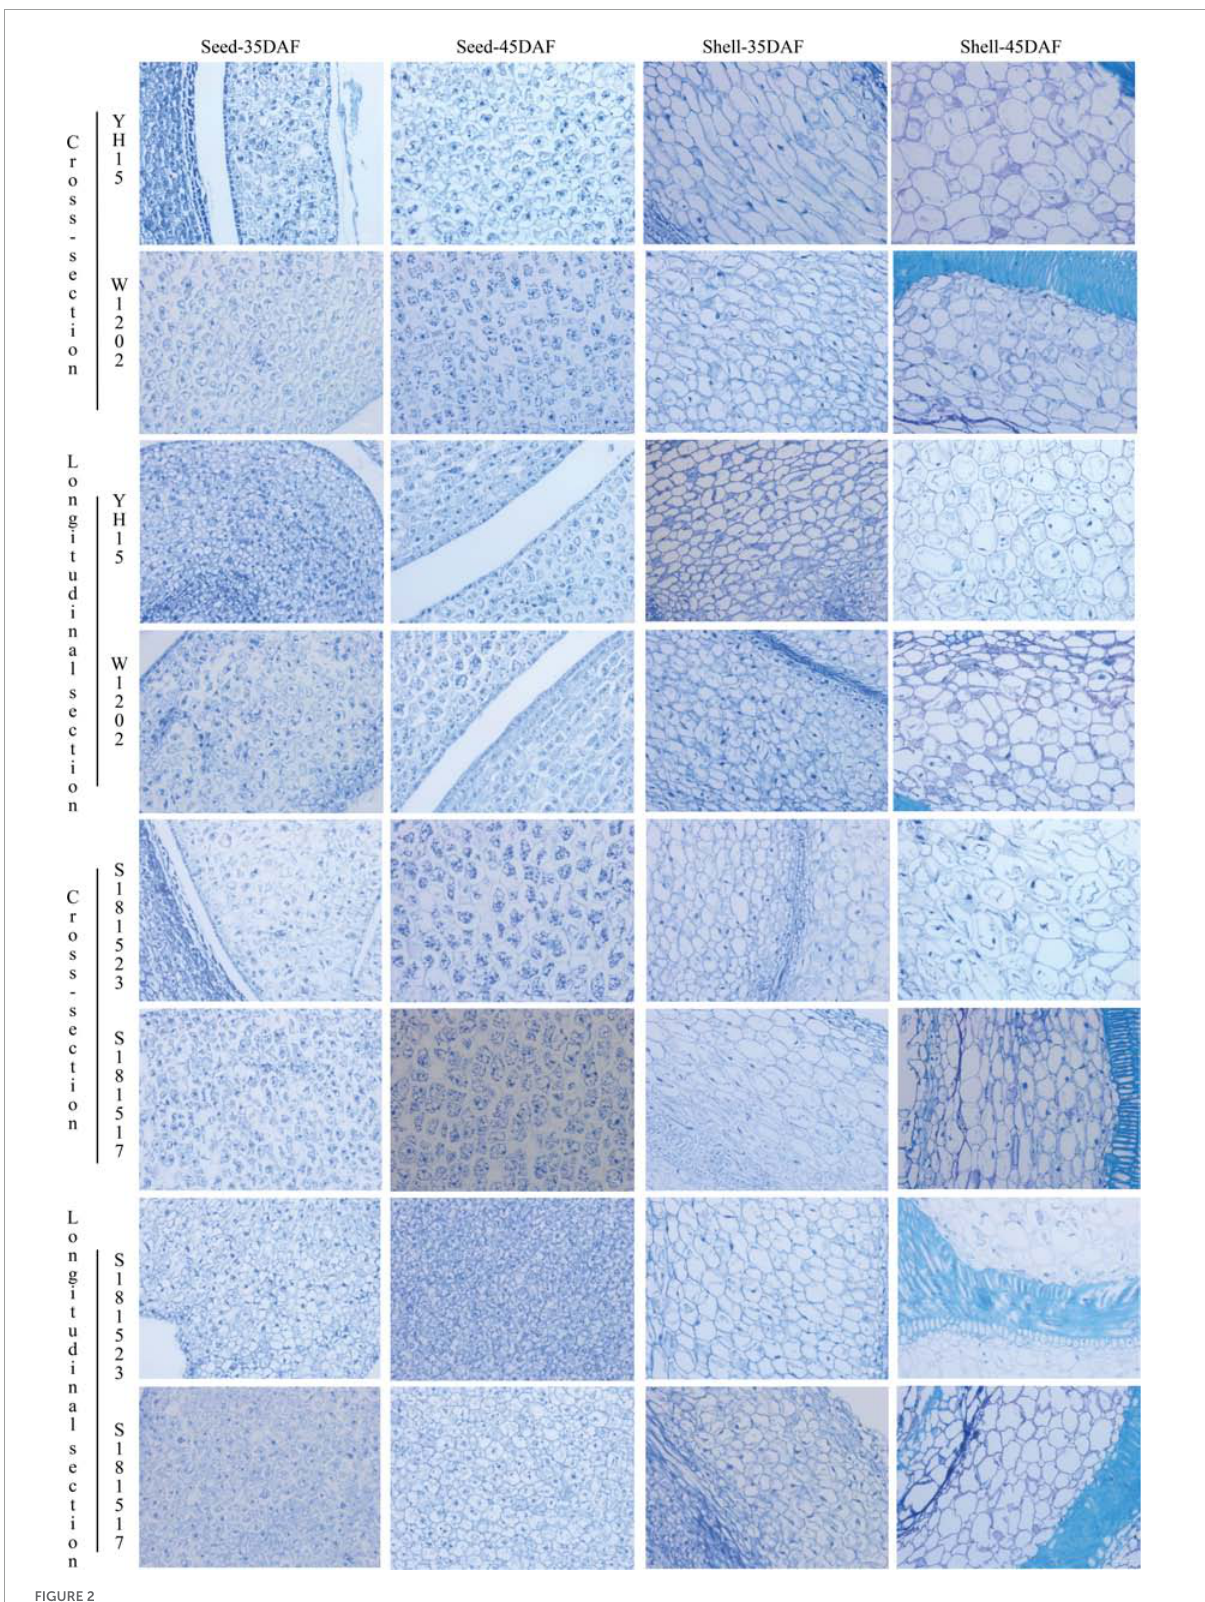
FIGURE2 Paraffin sections of peanut seed and shell. All magnifications are × 20. 20 × Bar = 10 µ